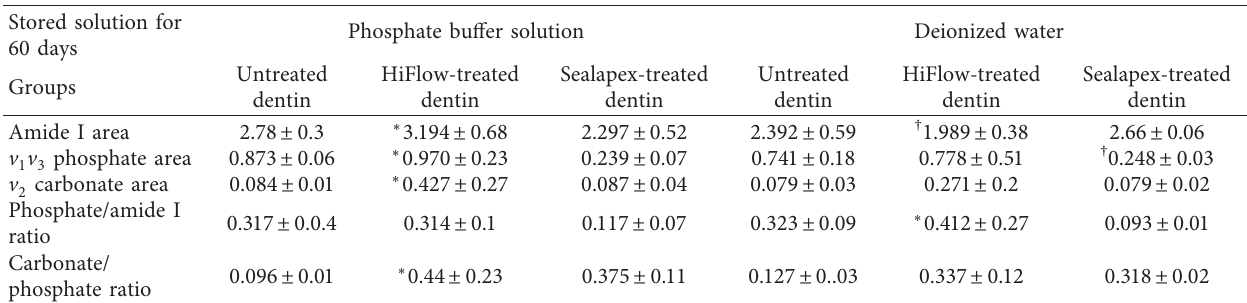
Table 1: Mean ± standard deviation values of all parameters extracted from FTIR spectra of all investigated dentin stored in either phosphate buffer solution or deionized water for 60 days; these parameters include integrated area under bands of amide I, v (at 1720–1580, 1200–900, and 890–830cm − 1 ), and phosphate/amide I and carbonate/phosphate ratio.